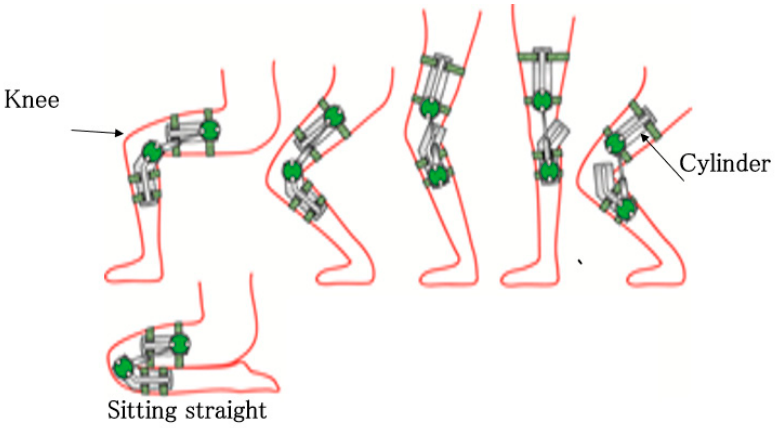
Figure 3. Shock mitigation and absorption